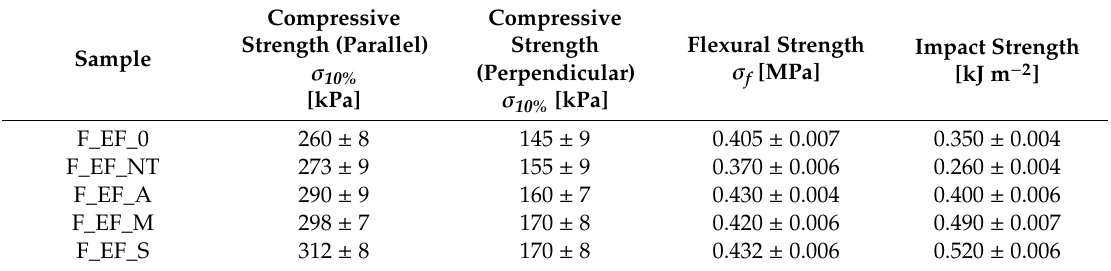
Table 4. The results of the mechanical properties of polyurethane foams modified with eucalyptus fibers.